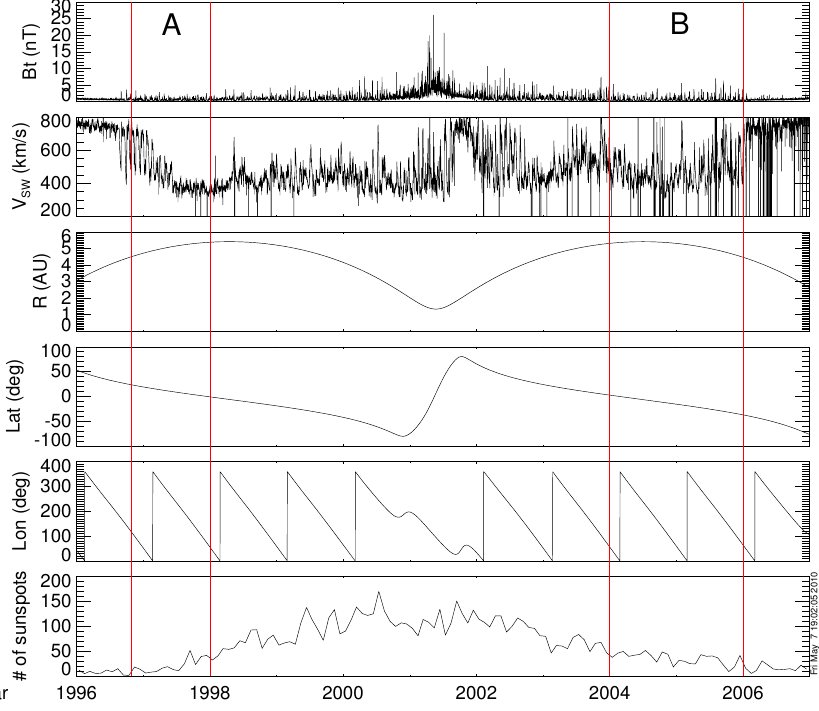
Fig. 1. Ulysses observations of the solar wind magnetic field B t , and the solar wind speed V SW as well as the locations of the spacecraft, given by the heliocentric distance R , the latitude Lat and the longitude Lon. The number of sunspots is plotted in the bottom panel (from Royal Greenwich Observatory – USAF/NOAA Sunspot Data). Time period is from 1996-001 to 2006-365. The regions A and B used in this work are marked by the red